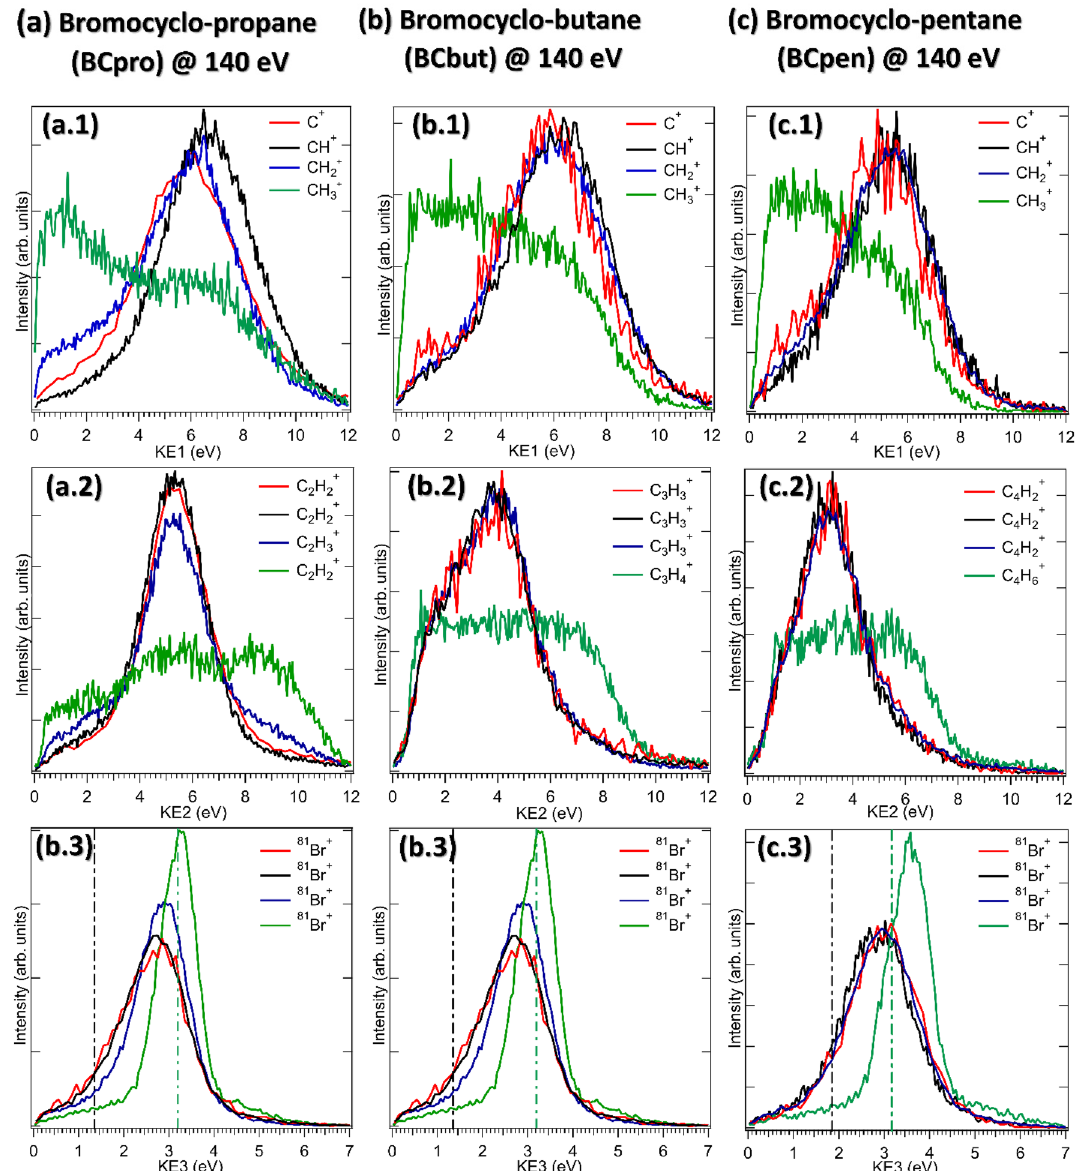
Figure 6. The kinetic energies of the individual fragments in different fragmentation channels of ( a ) BCpro, ( b ) BCbut, and ( c ) BCpen. The same color in top, middle and bottom row marks the fragments belonging to the same fragmentation channel. All distributions are normalized to have equal integral yield. The vertical, dash- dotted lines in the bottom row show the simulated Br + KE values for concerted (black) and sequential (green)